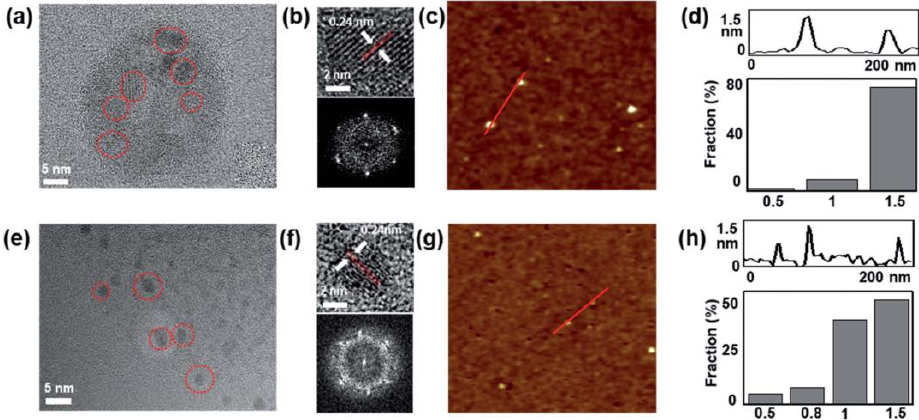
Figure 29. Effect of laser wavelength on the synthesis of GQDs ( a , b , c , d ) and GOQDs ( e , f , g , h ). [68]